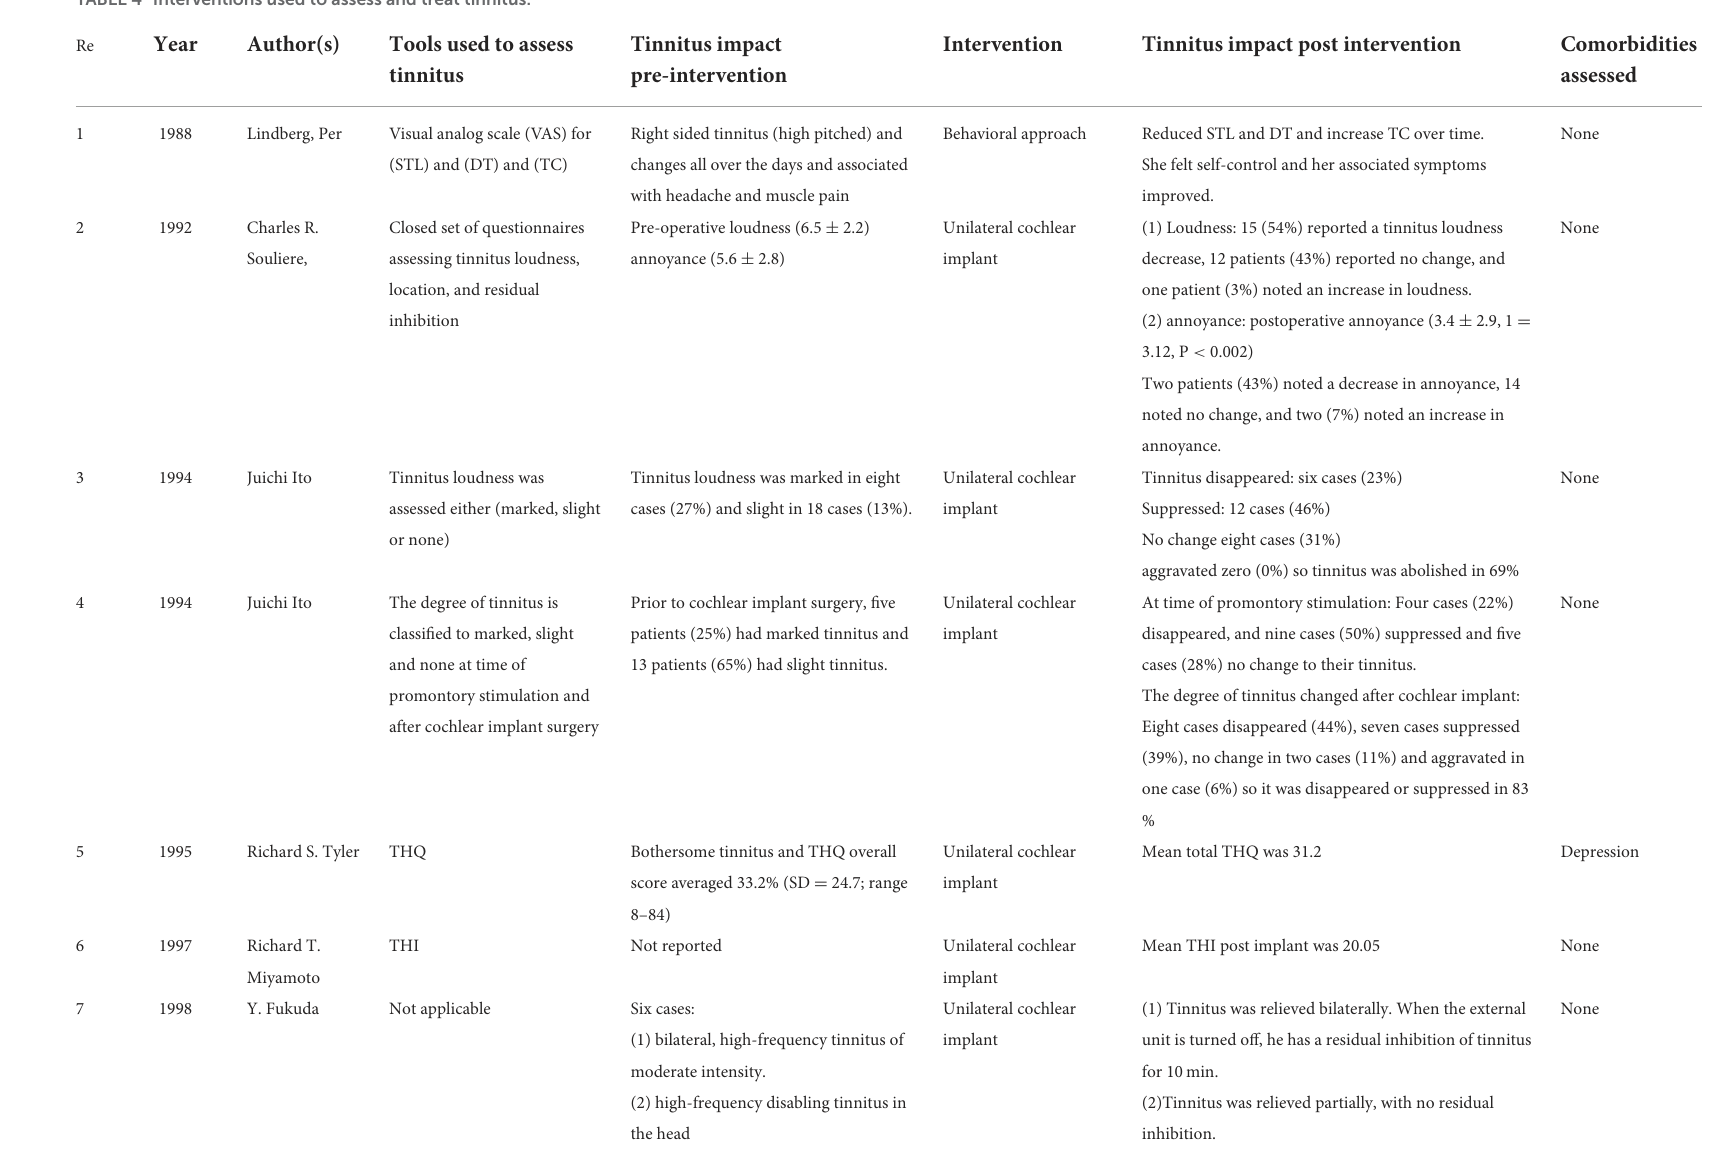
TABLE 4 Interventions used to assess and treat